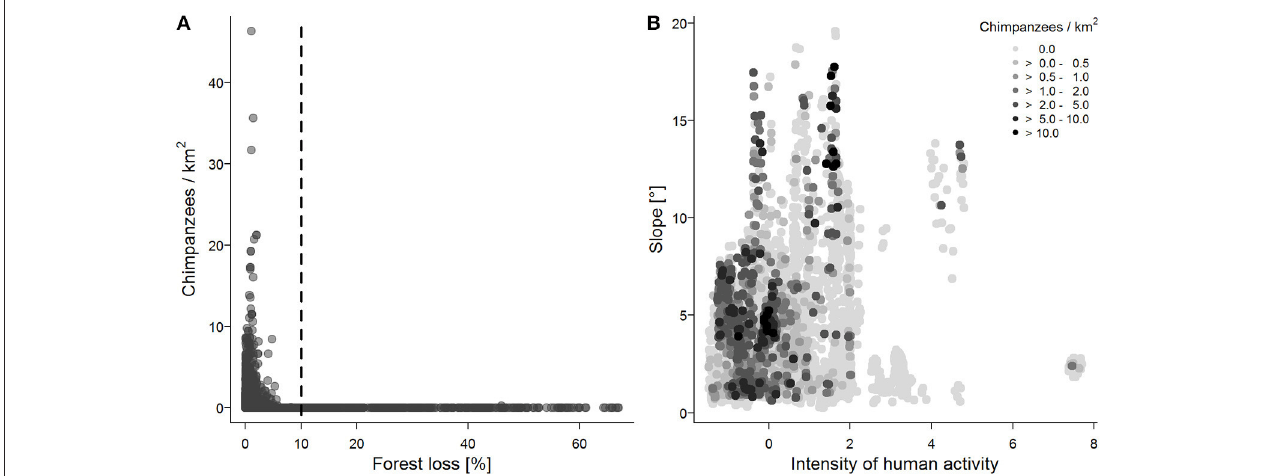
FIGURE 2 | Chimpanzee density as a function of (A) forest loss (data points drawn in transparent colors to visualize overlapping points), and (B) slope and human activity. Chimpanzee nests were found on transects with < 10% forest loss (dashed vertical line). Chimpanzees mainly occurred on transects with low intensity of human activity, but in areas with higher human activity higher chimpanzee densities were found in steeper areas, i.e., a refuge effect.